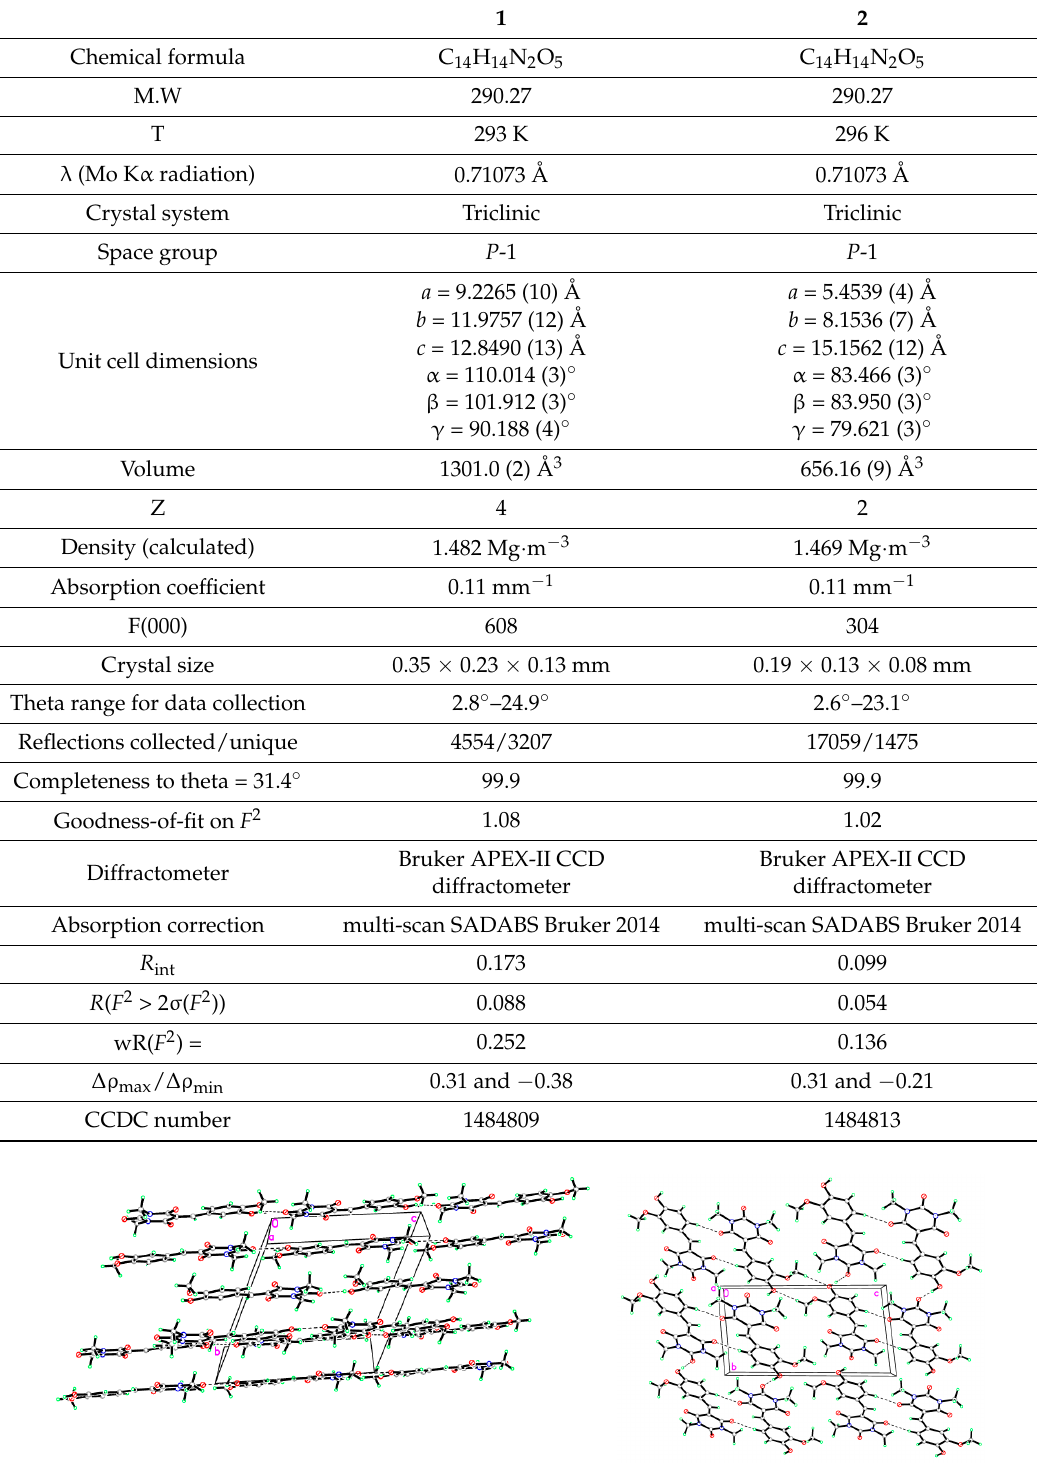
Table 1. The crystal and experimental data of 1 and 2 .